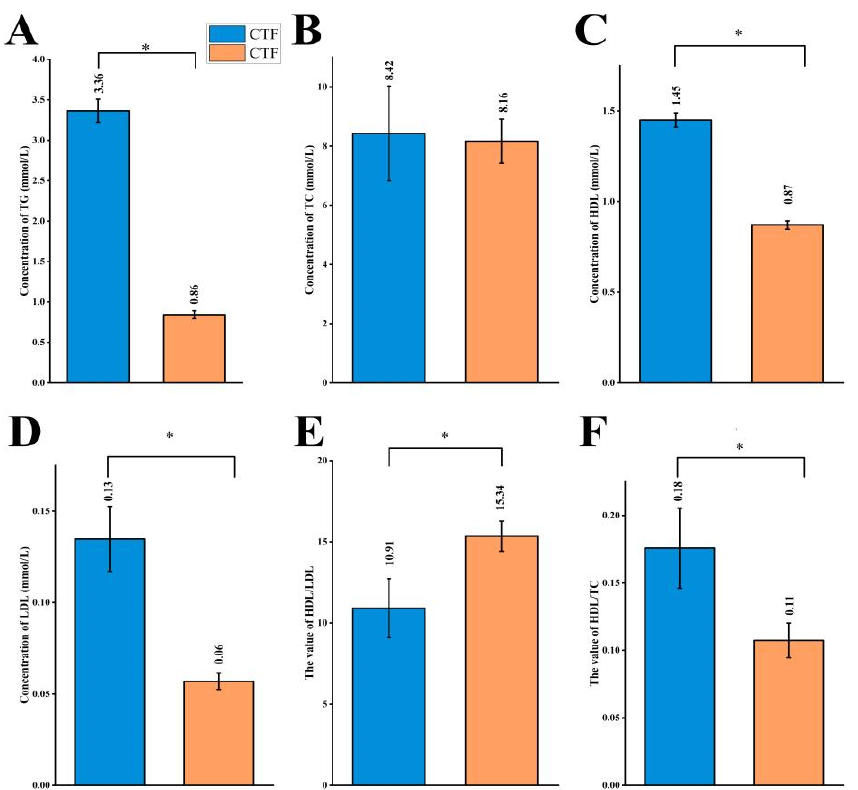
Figure 2. Plasma in CTF and LTF. ( A ) The concentration of TG of Sunit sheep in two feeding methods. ( B ) The concentration of TC of Sunit sheep in two feeding methods. ( C ) The concentration of HDL of Sunit sheep in two feeding methods. ( D ) The concentration of LDL of Sunit sheep in two feeding methods. ( E ) The value of HDL-to-LDL of Sunit sheep in two feeding methods. ( F ) The value of HDL-to-TC of Sunit sheep in two feeding methods. “*” indicates a significant difference between the two groups ( p < 0.05).